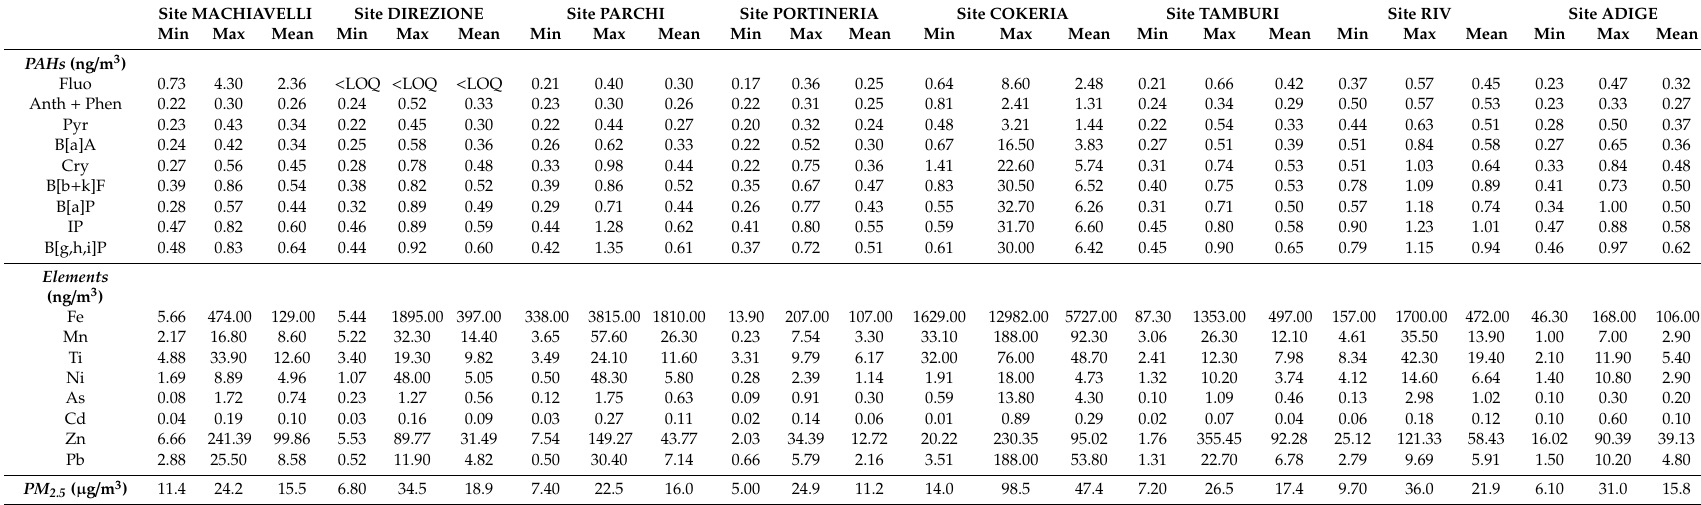
Table 3. PAHs, elements and PM 2.5 concentrations: minimum, maximum and average values for all the investigated sites over the period 9–28 December 2014. Site